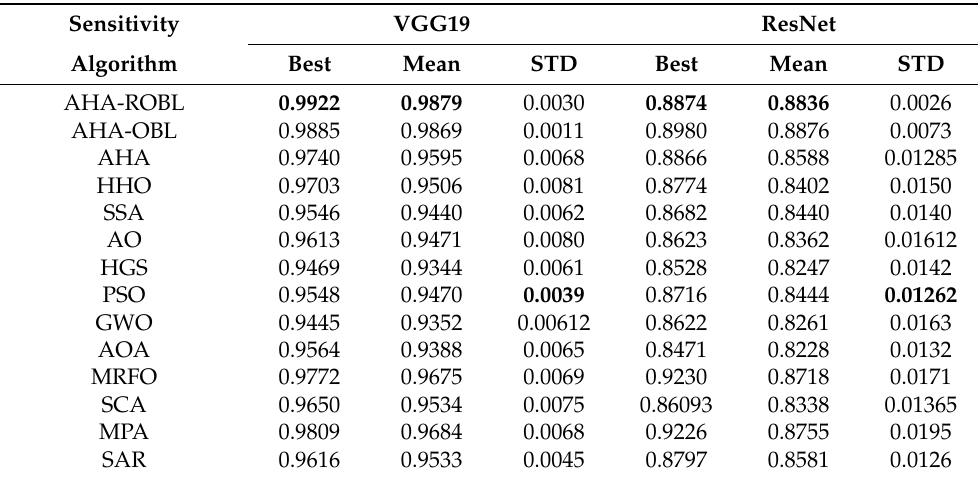
Table 6. Comparison of the performance of deep feature models of the AHA-ROBL with other recent optimizers versus avg. sensitivity.